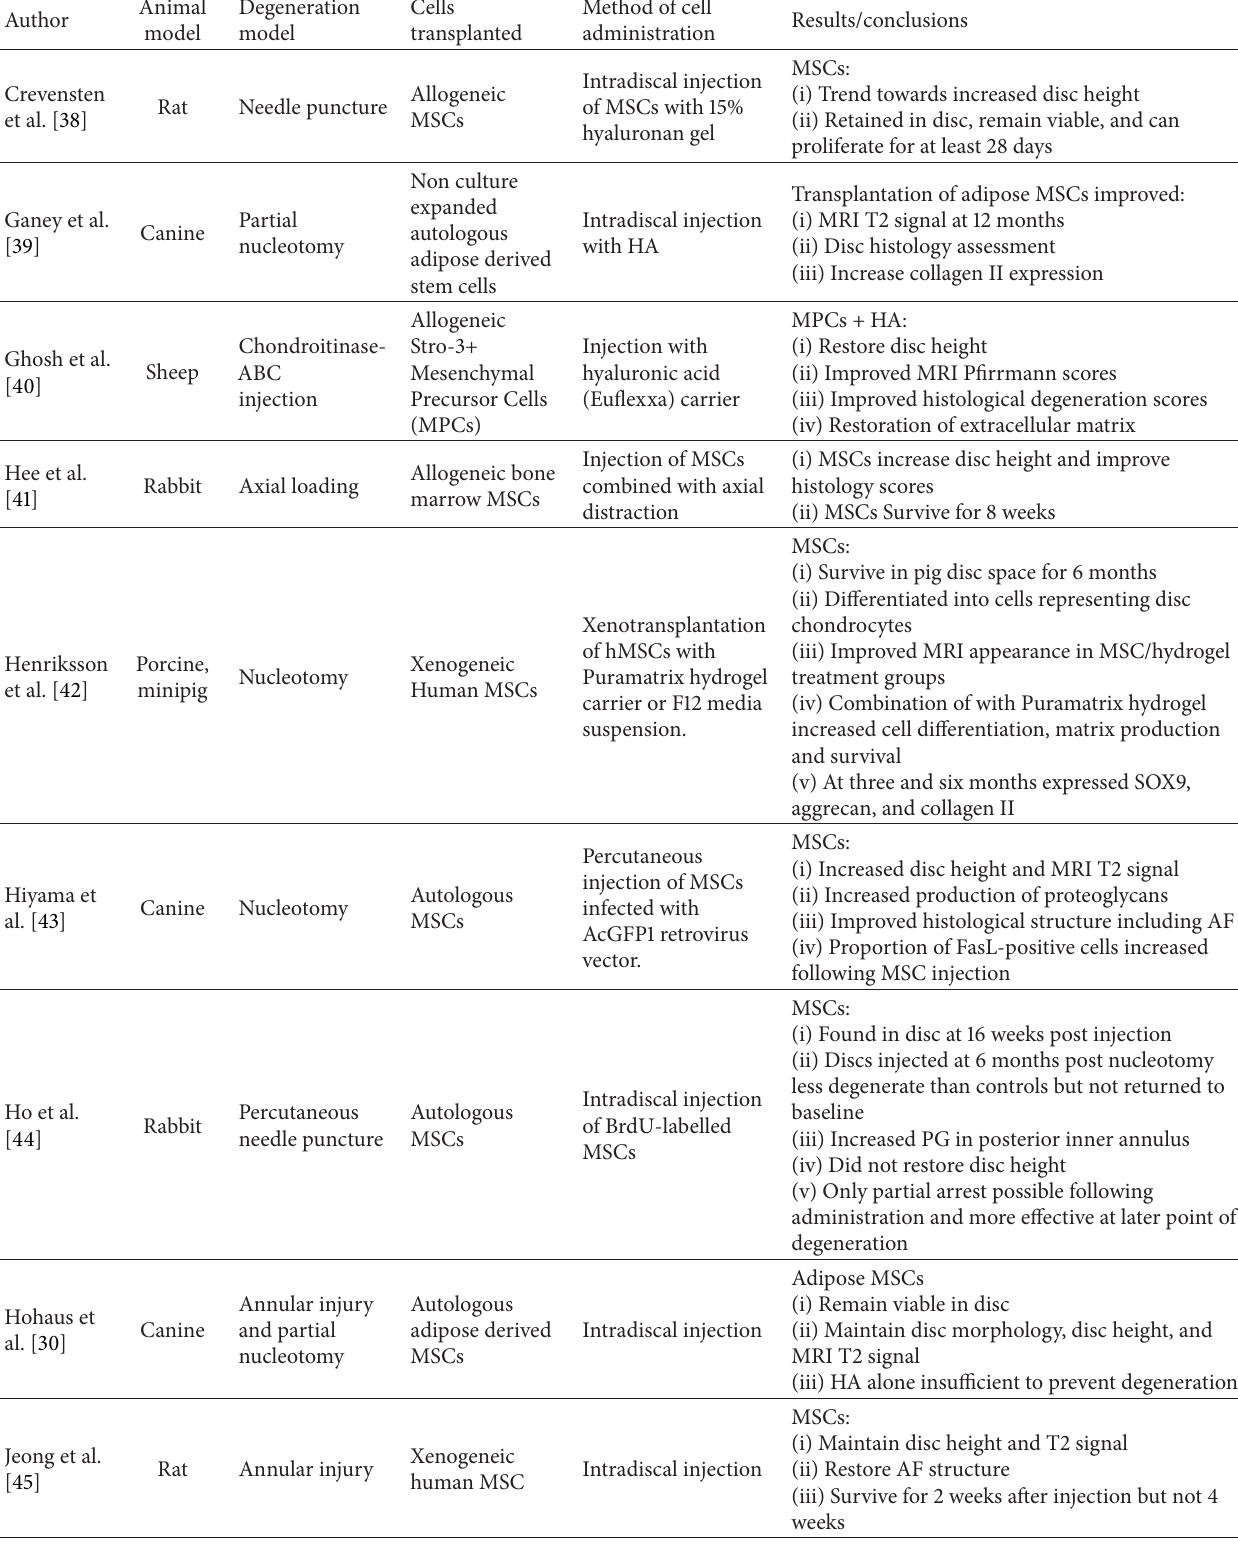
Table 2: Studies assessing the ability of different types of stem cells or progenitor cells to regenerate lumbar intervertebral